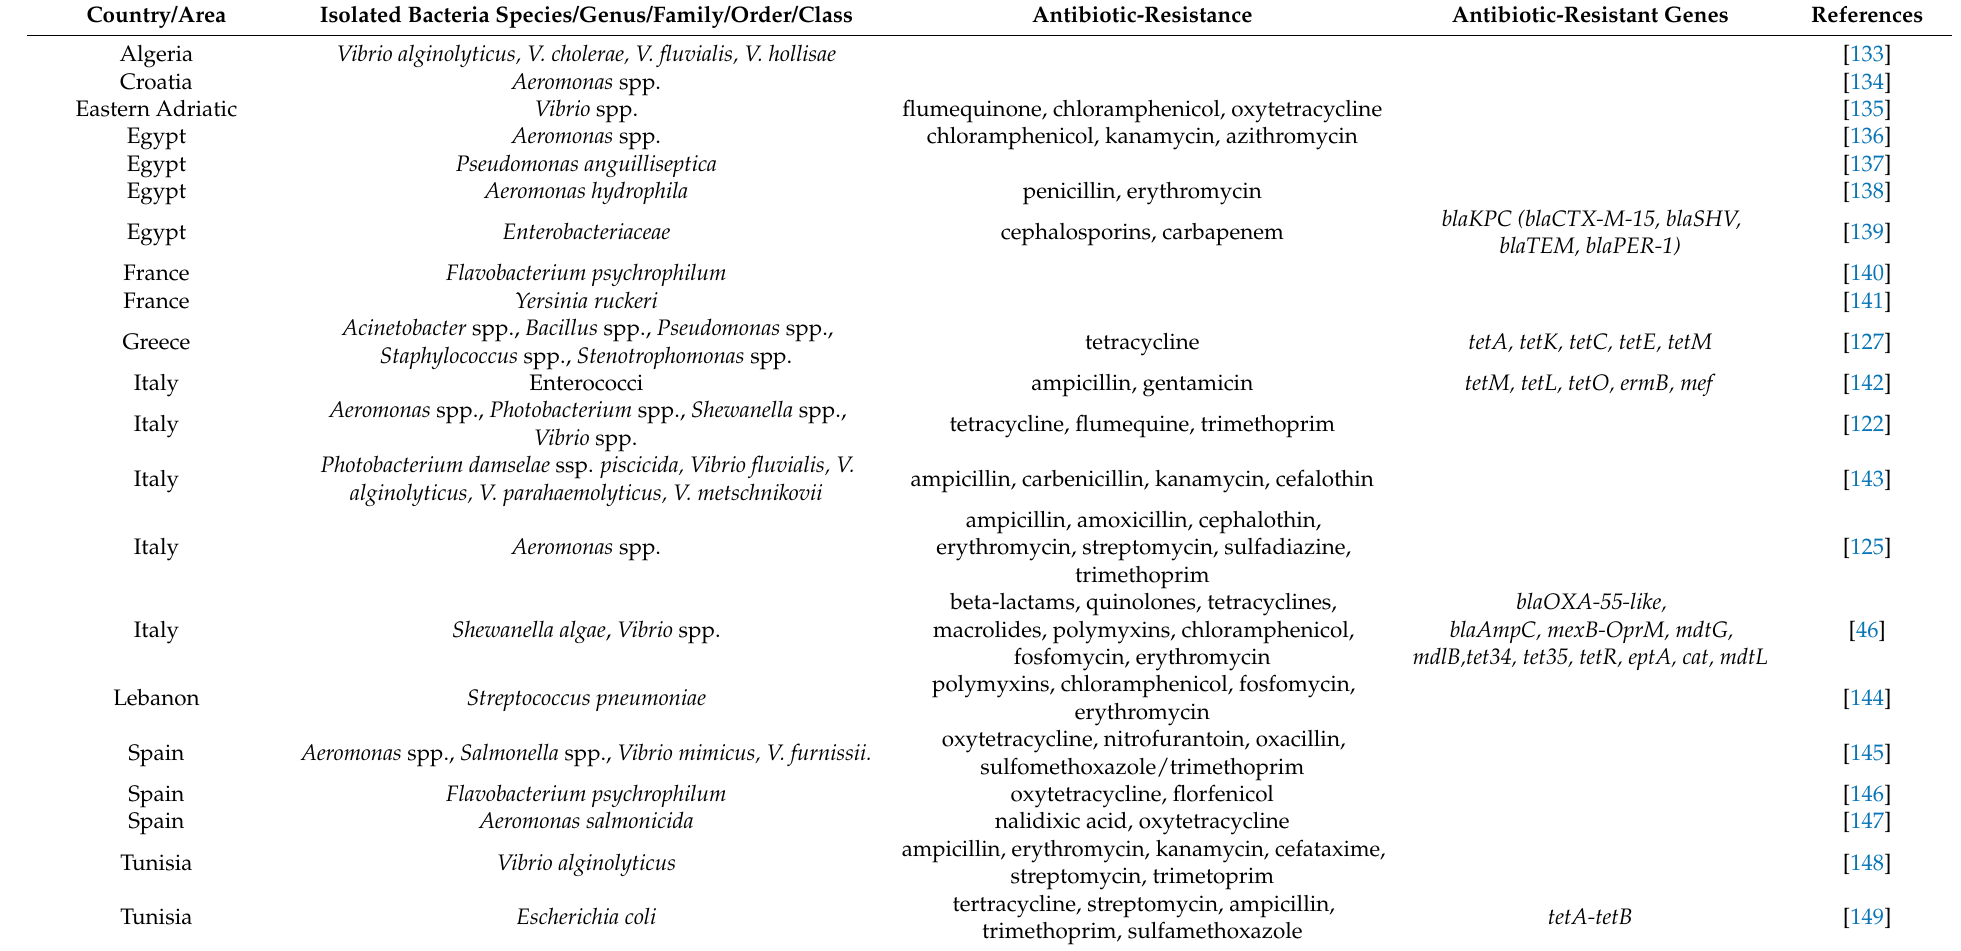
Table 3. Bacteria isolated from aquaculture in the Mediterranean area, antibiotic resistance and antibiotic-resistance genes.